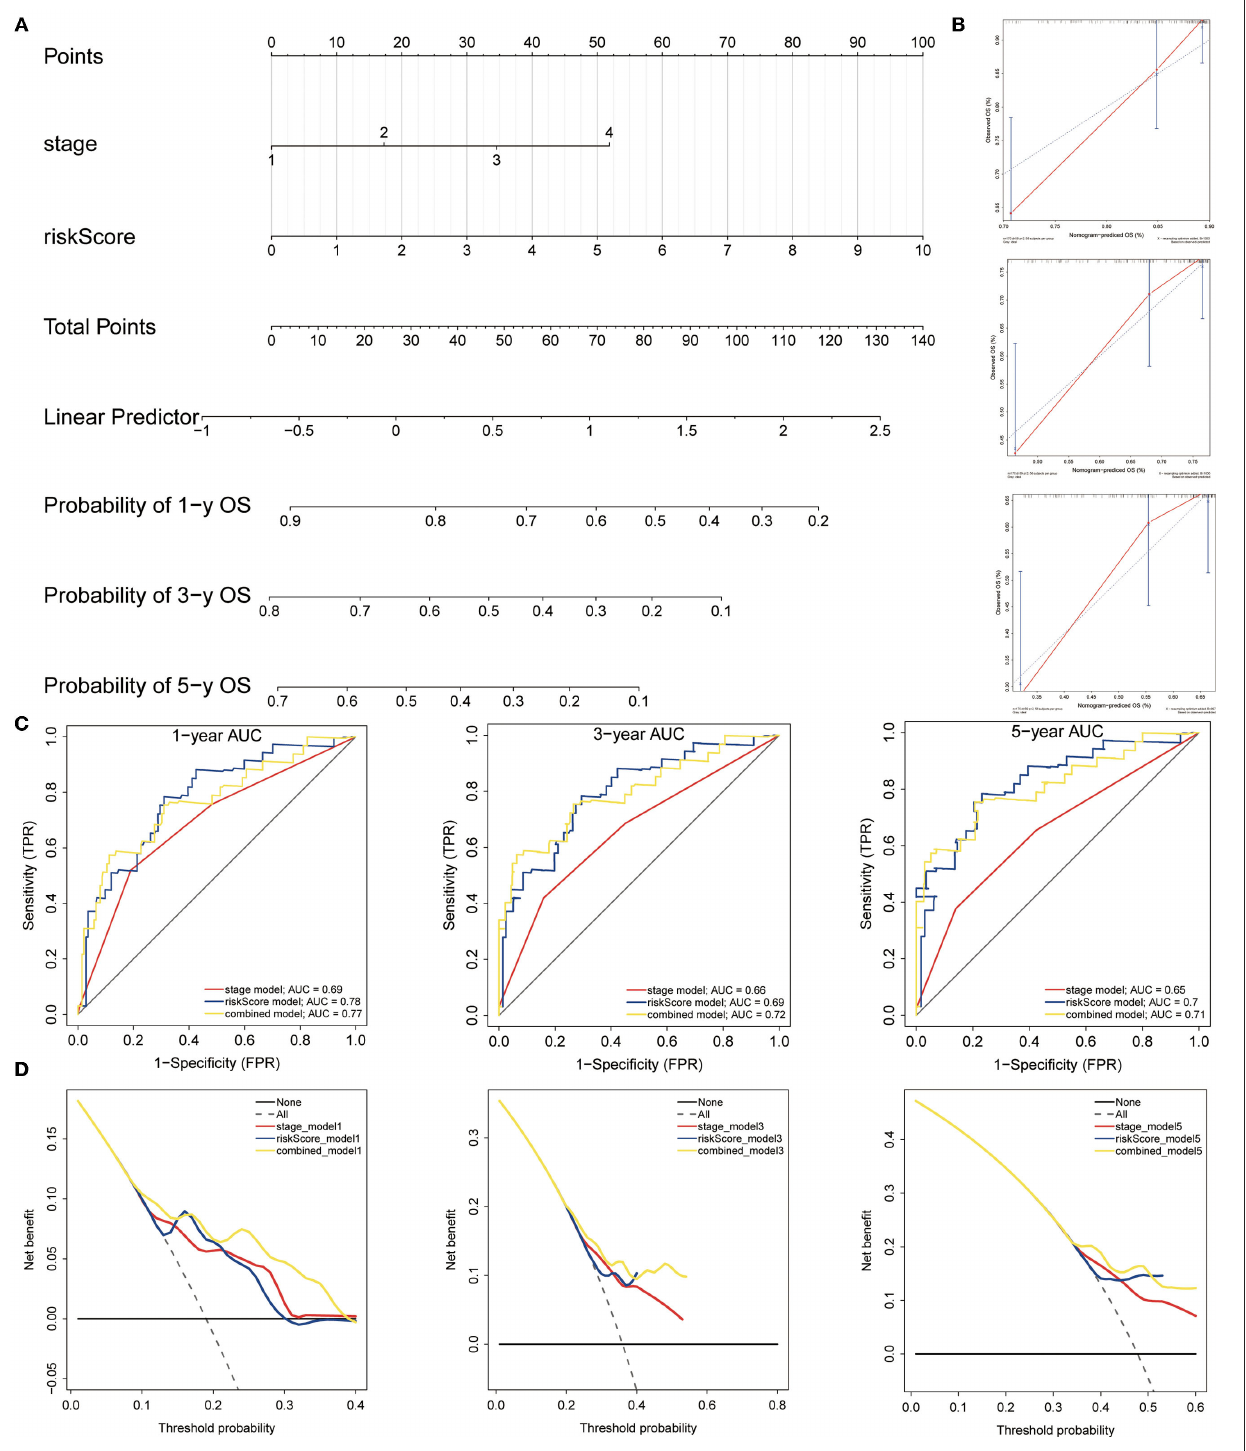
FIGURE 12 | Construction and evaluation of the nomogram. (A) The nomogram of 3-gene prognostic signature in the TCGA cohort. (B) Calibration plots of the nomogram for estimation of survival at 1-, 3-, 5- year. (C) ROC curves showed the predictive efficiency of the nomogram. (D) Relations between net benefit and threshold probability at 1-year, 3-year, and 5-year survival